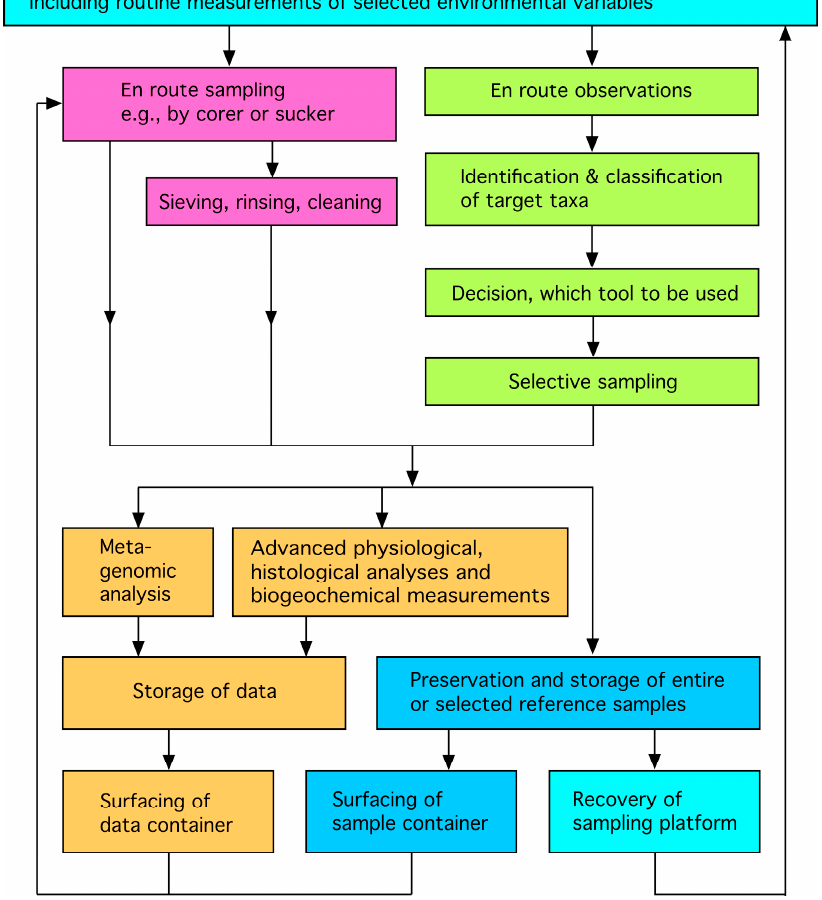
Figure 7. Hypothesized workflow from a sampling platform carrying out an a priori programmed mission, including routine measurements of environmental variables, such as water mass characteristics and small-scale bottom topography (turquoise). The concept can comprise: en route sampling (pink); event-triggered sampling with en route observations (green); genetic and other biological and biogeochemical analyses with surfacing of data saved in a data container (beige); preservation and surfacing of samples (blue). For a further description, see Section 3.2.